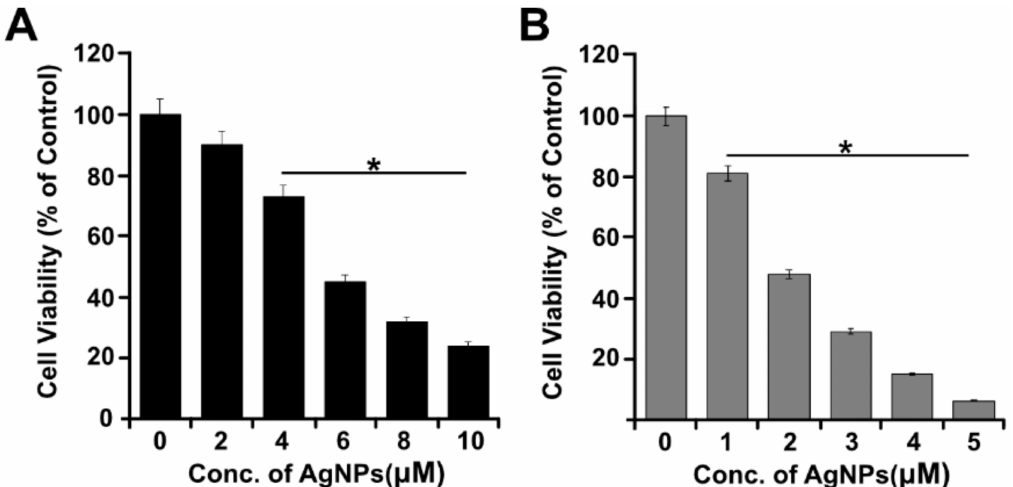
Figure 2. Dose-dependent effect of 40 and 5 nm AgNPs in A549 cells. ( A ) A549 cells were incubated with various concentrations of 40 nm AgNPs (2–10 µ M) for 24 h, and cell viability was measured using CCK-8. ( B ) A549 cells were incubated with various concentrations of 5 nm AgNPs (1–5 µ M) for 24 h, and cell viability was measured using CCK-8. The results are expressed as the mean ± standard deviation of three separate experiments. Statistically significant differences between the treated and control group are indicated by (* p <